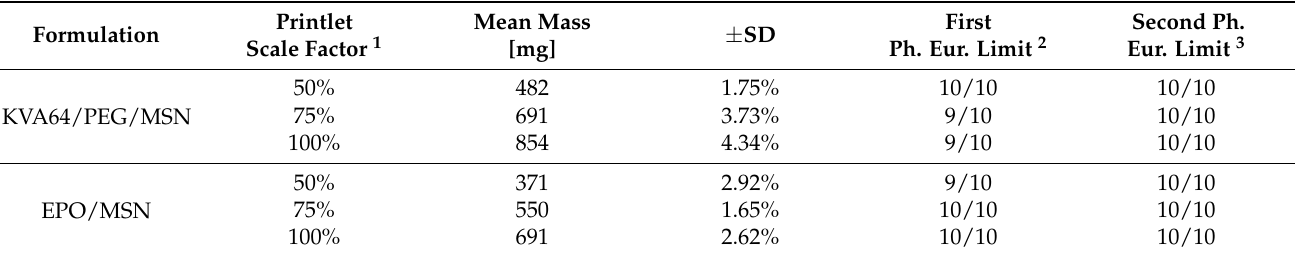
Table 3. Comparison of average printlet mass, standard deviation, and mass uniformity limits for formulations KVA64/PEG/MSN and